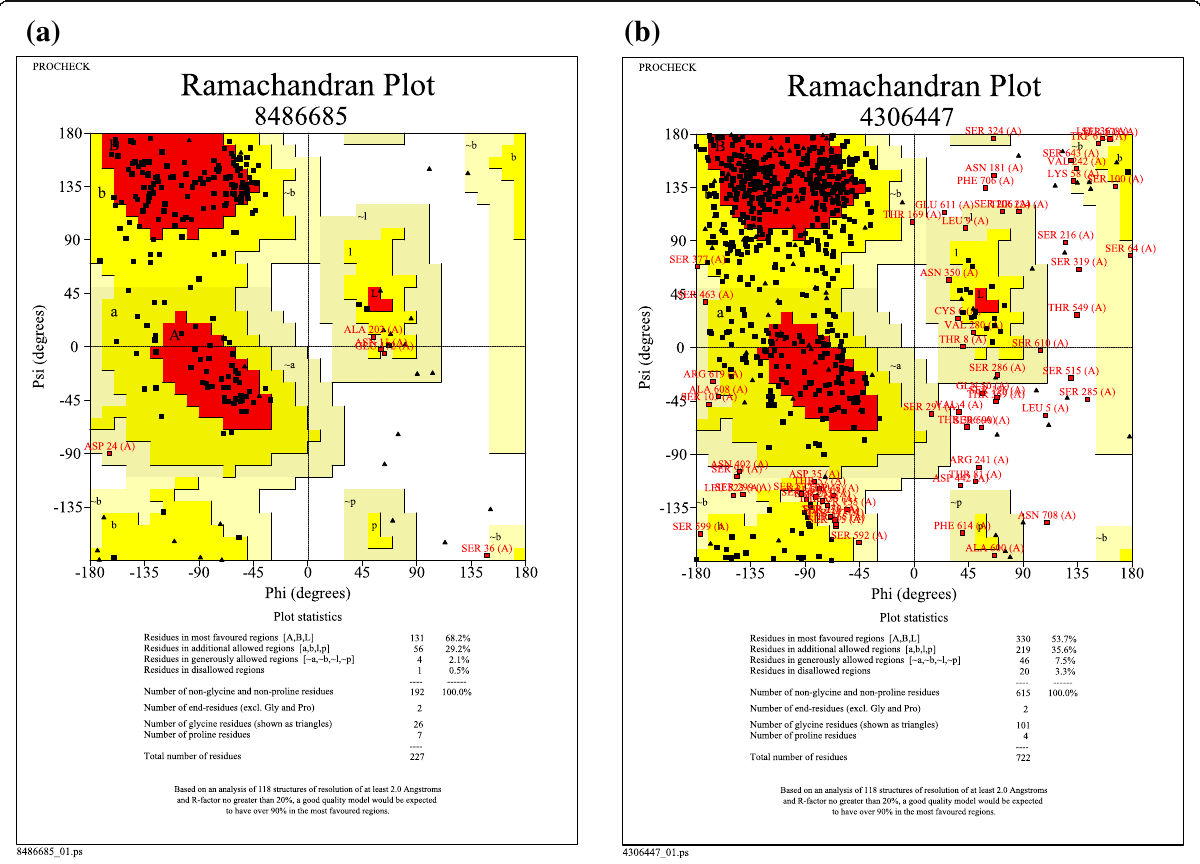
Fig. 9 A Ramachandran plot output (modified from PROCHECK) of cocoonase ( a ) and sericin ( b ). The plot calculations were computed by PROCHECK server. The red regions in the graph indicate the most allowed regions; additional allowed, generous allowed, and disallowed regions are indicated as yellow, light yellow, and white fields, receptively. The Ramachandran plot for cocoonase disclosed 68.2% of amino acid residues within the most favored region. Similarly, Ramachandran plot for sericin disclosed 53.7% of amino acid residues within the most favored